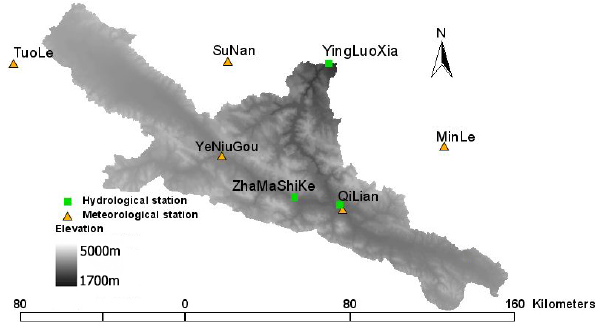
Table 2. Basic information of meteorological stations in the upper basin of Heihe